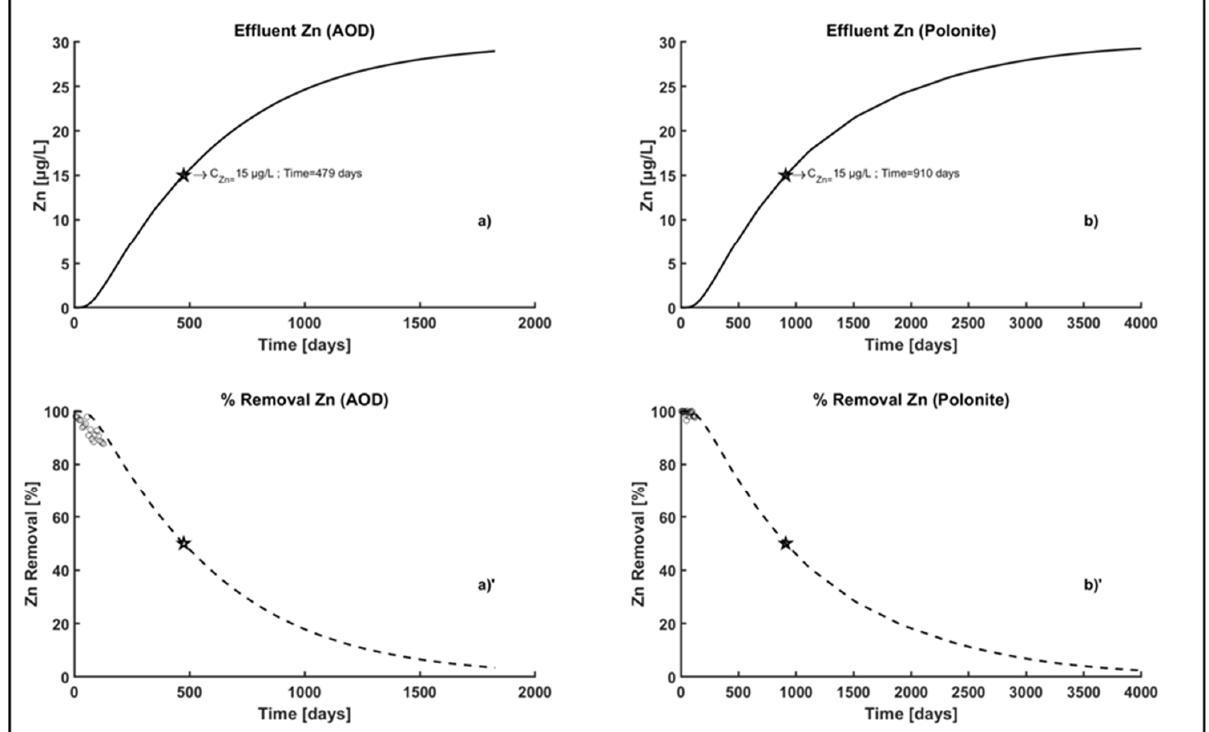
Figure 5. Capability of the model. Profile of the concentration and percentage removal of Zn within time for AOD and Polonite. Star indicates the maximum limit value according Järfälla municipality and circles refers to the experimental data. ( a )’ and ( b )’ are the percentage removal of Zn correspondingly to ( a ) and ( b ).